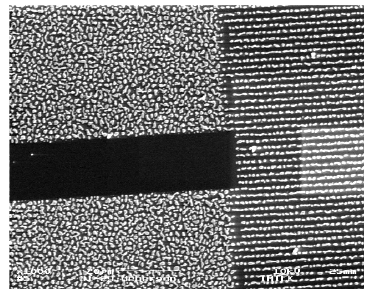
Figure 9. Dewetted metal layer after heating up to 800 ◦ C.